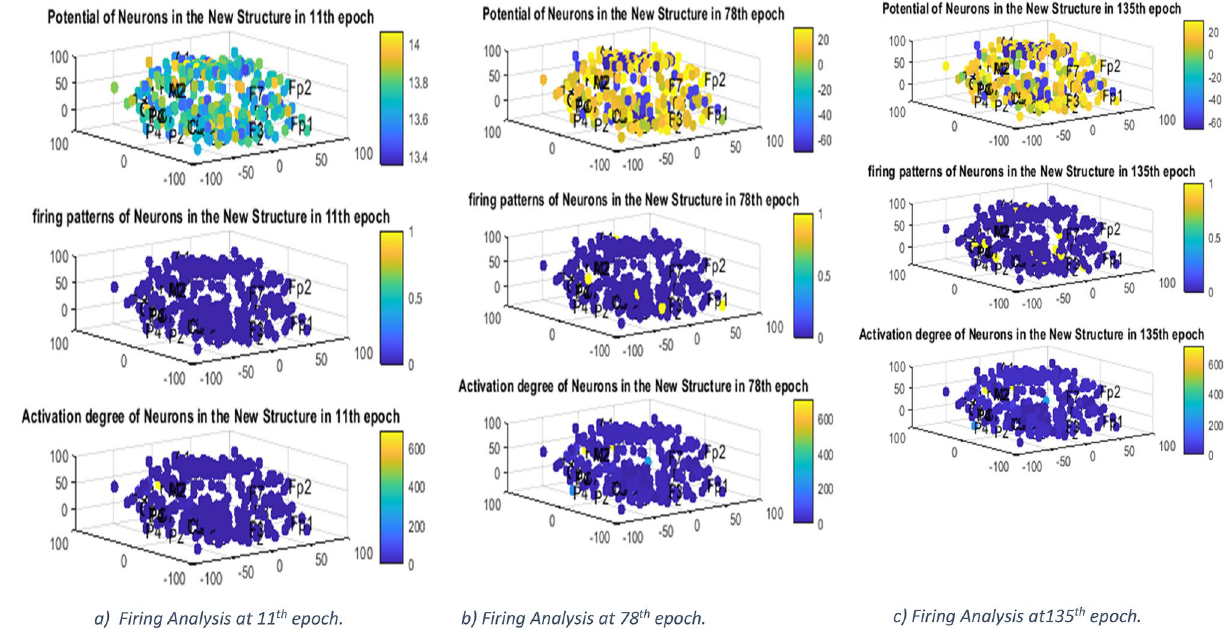
Figure 5. Distribution of membrane potentials of the neurons in the MRI-cSNNr (the first figure); firing patterns of the neurons (second figure) and activation degree of the spiking neurons (third figure) at: ( a) 11th epoch, (b) 78th epoch, (c) 135th epoch of incremental training. The input neurons allocated for the corresponding EEC channels are labelled by the names of the